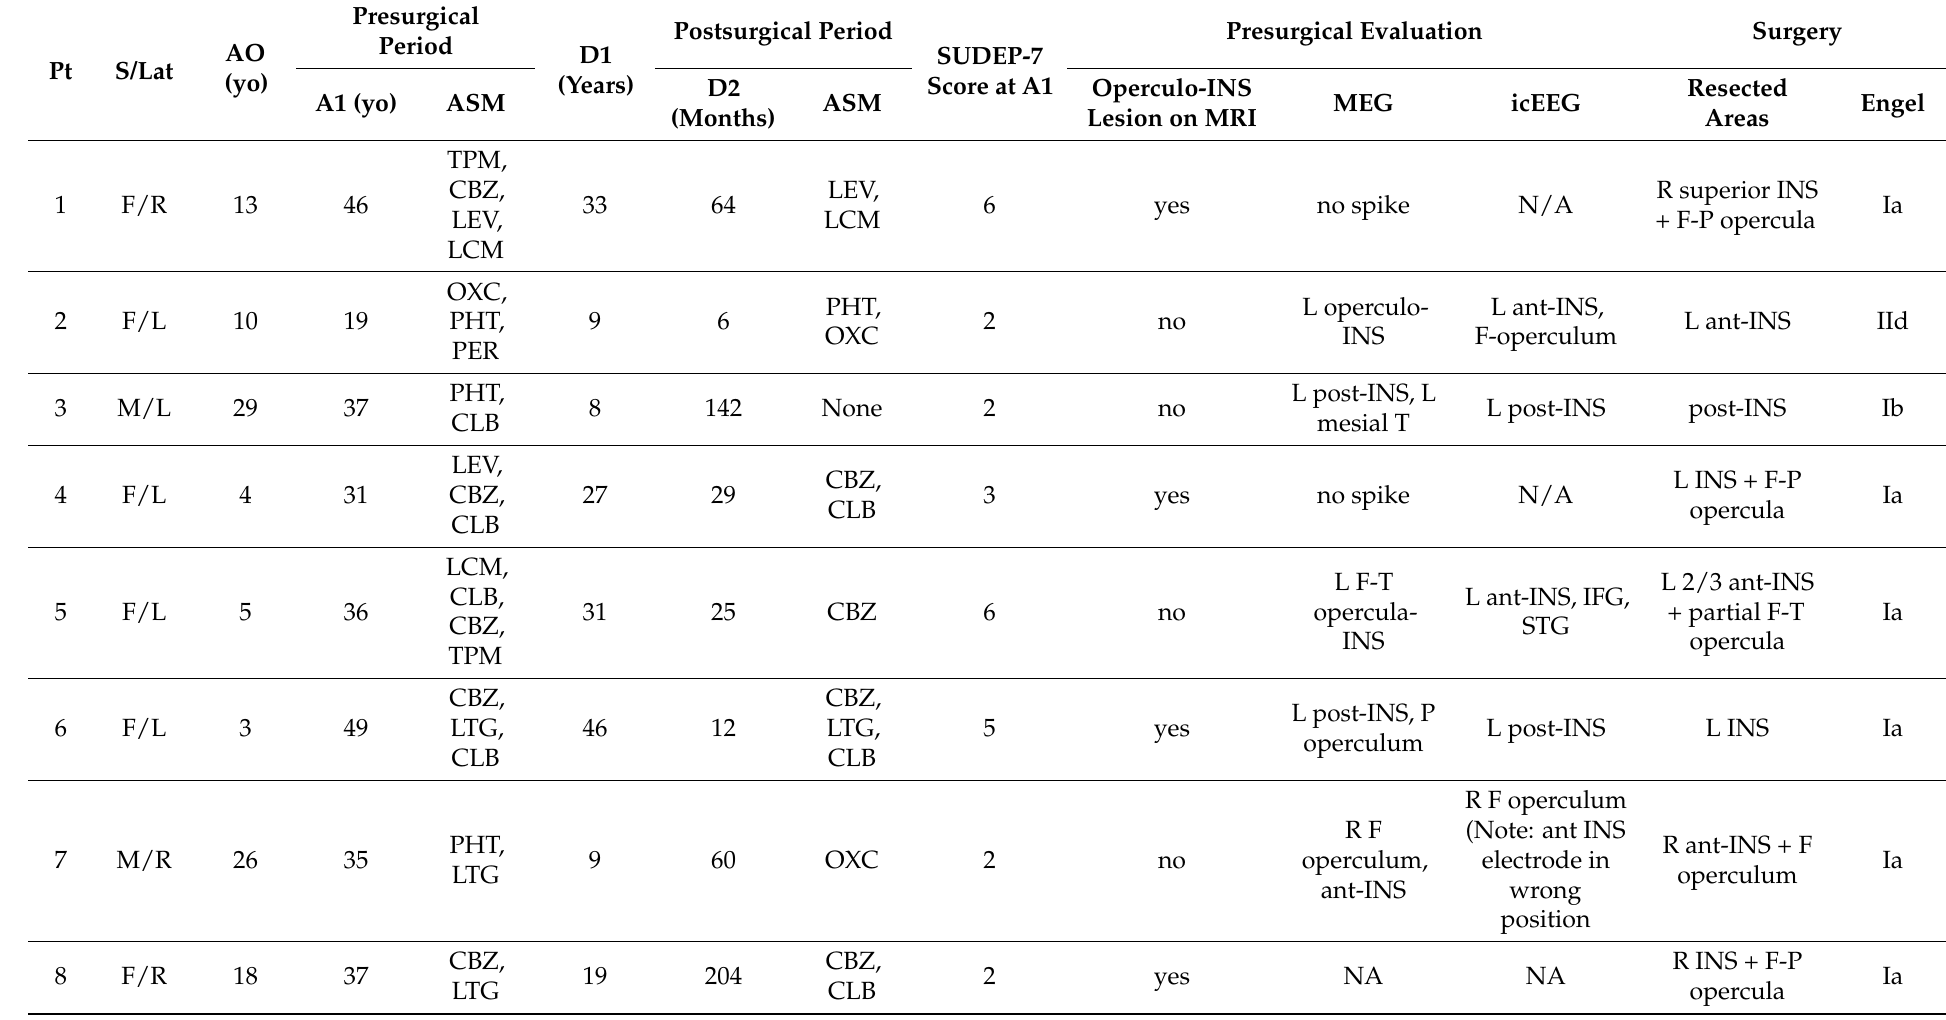
Table 1. Summary of presurgical, surgical and postsurgical data of IOE